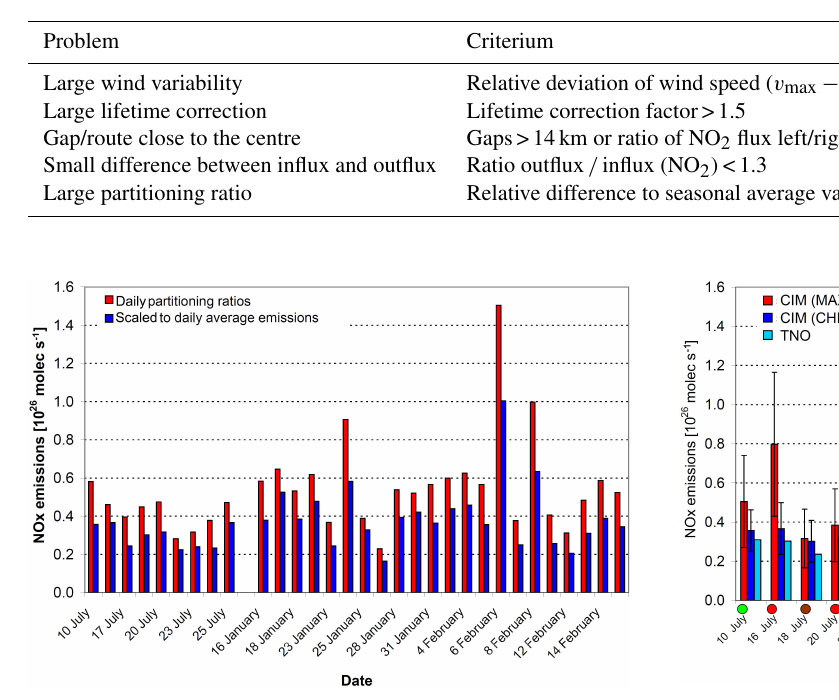
Figure 17. Comparison of the NO x emissions derived from the car MAX-DOAS measurements (red) with the CHIMERE model sim- ulations (blue) and the corresponding TNO input emissions (light blue). All data represent daily average emissions. The NO x emis- sions from MAX-DOAS and CHIMERE were derived using daily partitioning ratios. Results are only shown for “good” measure- ment days (days with uncertainties in the car MAX-DOAS measure- ments>100% and with ratios of the CIM results for CHIMERE and TNO emissions above 1.7 and below 0.6 are left out). The coloured disks below the bars indicate potential problems of specific days (same scheme as in Fig. 16). Note that the following days are week- end days: Saturdays – 18 July, 17 January, 13 February; Sundays – 31